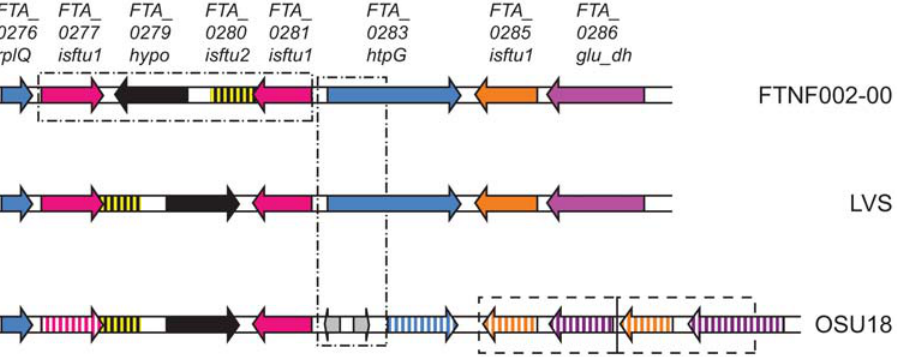
Figure 1. A 10 kb hypervariable genomic region carrying three regions of difference between the three F.t.holarctica genomes. Arrows indicate the direction of gene transcription. Genes and intergenic regions are not to scale. Homologous genes in the three genomes have been assigned the same color. Solid arrows indicate putative functional genes and hatched or grey arrows represent pseudogenes. The horizontal box on the FTNF002-00 chromosomal fragment indicates the 3,868 bp fragment (positioned at 247478–251345) that is inverted with respect to the other two genomes. A vertical box over the three genomes indicates the location of a 962 bp region that is different in OSU18 (see Table 2). The two equal sized horizontal boxes on the OSU18 genomic fragment indicate tandem duplications of a 1933 bp region (see Table 2).